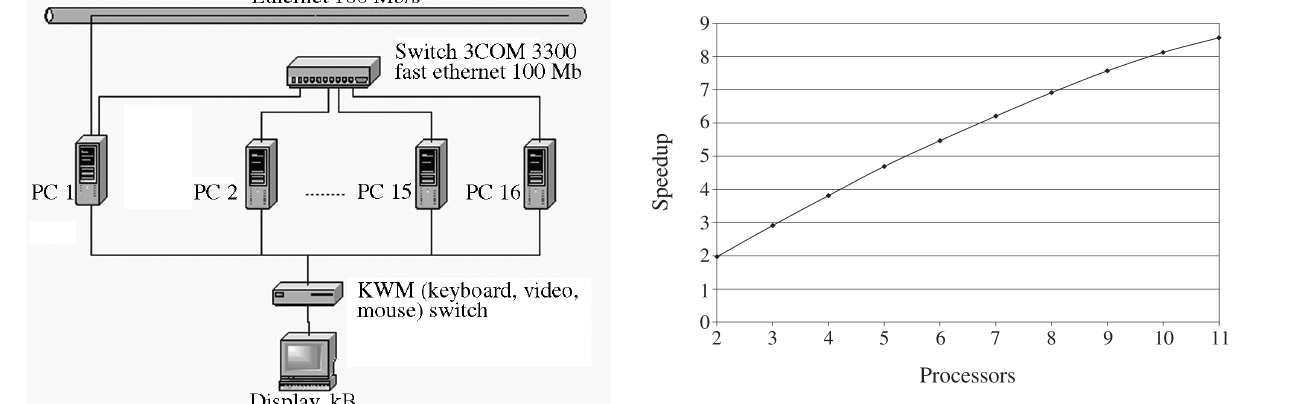
Figure 4 - Parallel platform.